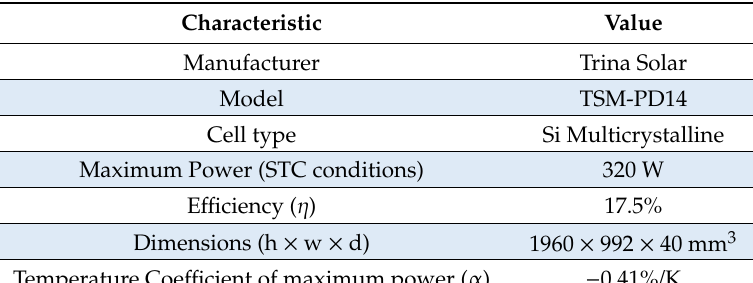
Table 9. Solar panel characteristics